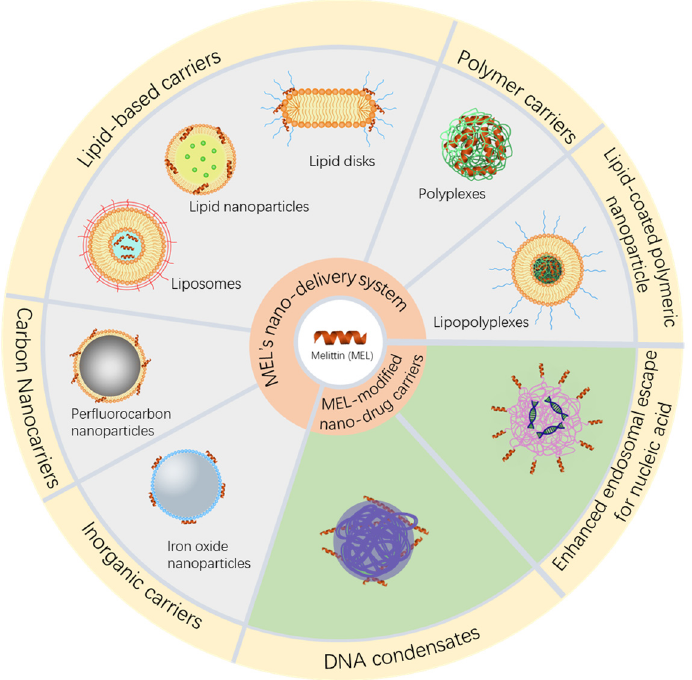
Figure 2. Strategies of MEL nano-delivery systems and MEL-modified nucleic acid nanocarriers for cancer therapy.